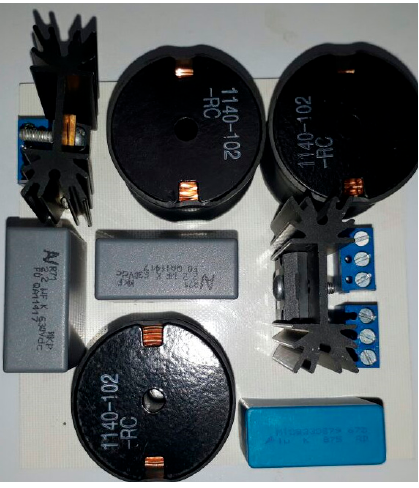
Figure 10. Electrical components of the experimental implementation of the Z-source converter.